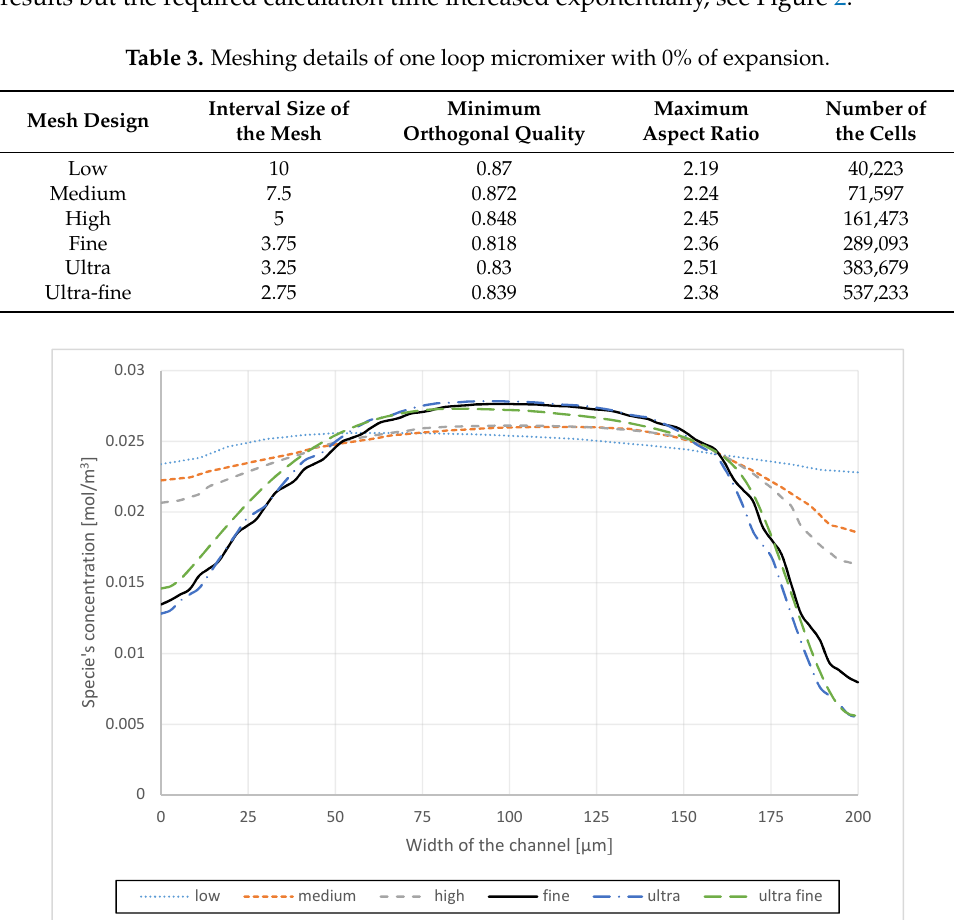
Table 2. Physical properties of water and diluted ink.